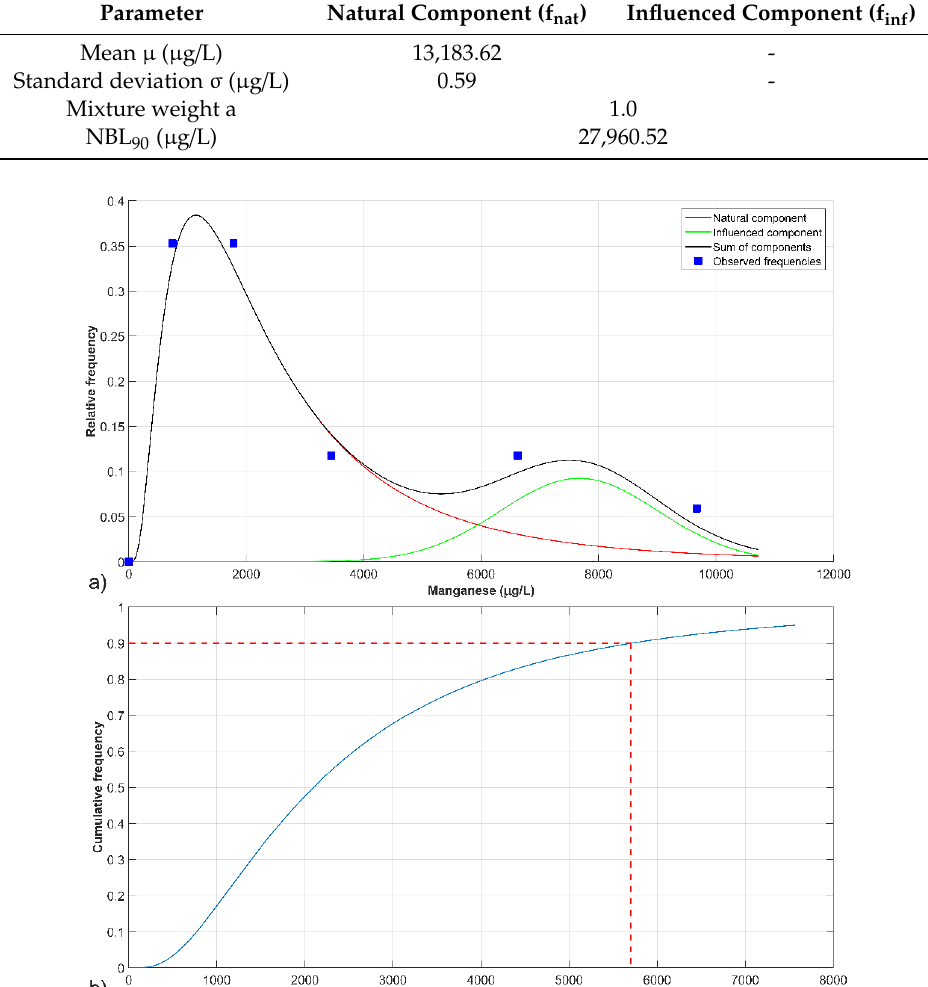
Figure 7. GuEstNBL output: ( a ) Manganese empirical frequencies together with the estimated natural and anthropogenic components, and their weighted sum distribution; ( b ) CDF and 90th percentile of the identified log-normal PDF.